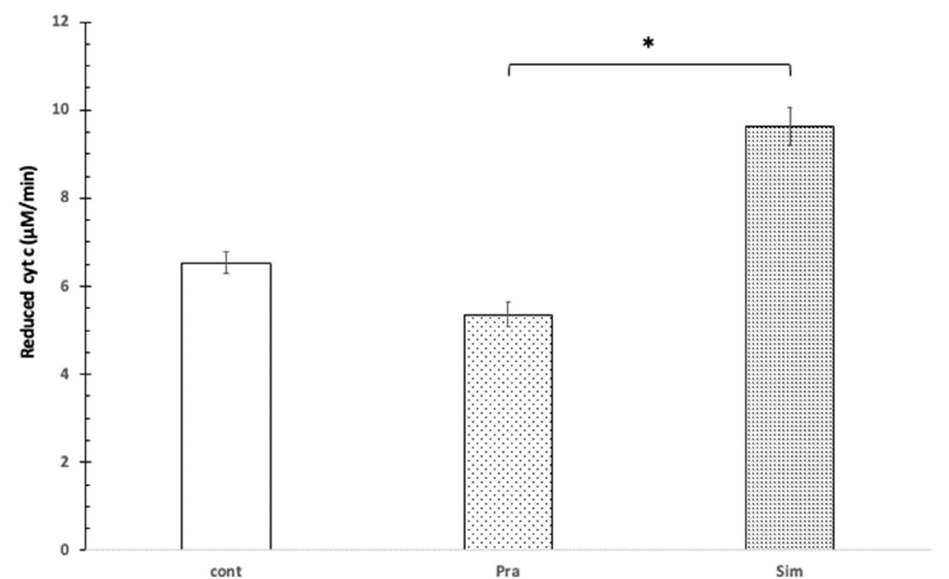
Figure 2. The effect of pravastatin and simvastatin on cytochrome c reduction in the presence of Mg 2+ . 100 µ M cytochrome c, control without pravastatin and simvastatin (cont), 100 µ M pravastatin (Pra), 100 µ M simvastatin (Sim), 100 mM Tris/HCl (pH = 8.0), 1 mM Mg 2+ , T = 25 ◦ C. * shows significant difference.